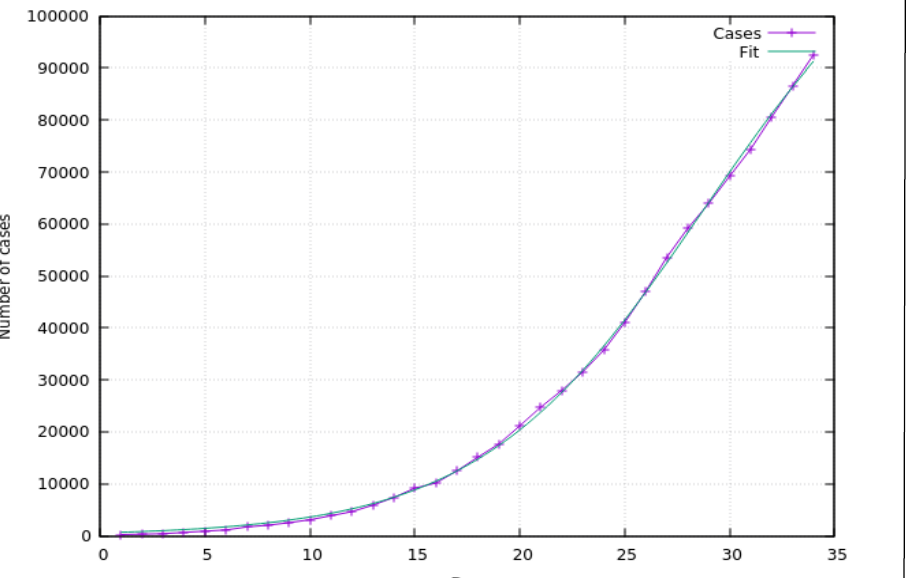
Figure 1 – Data fit: the number of cases with respect to the number of